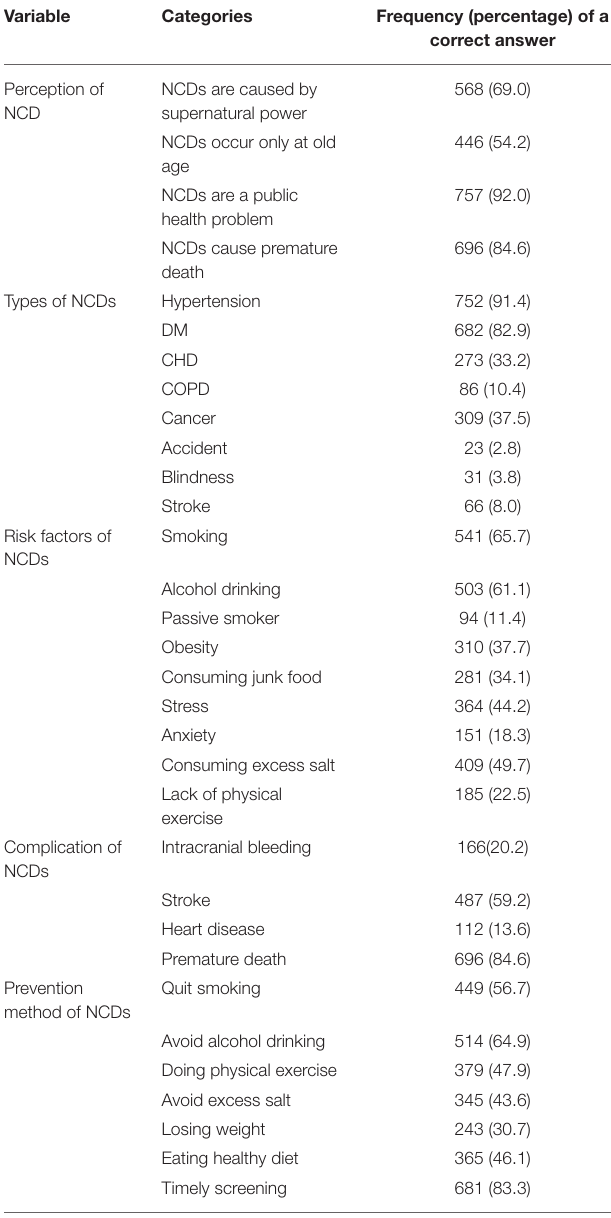
TABLE 2 | Knowledge measuring variables among adult residents of selected towns of north Shewa zone, Oromia region, central Ethiopia,